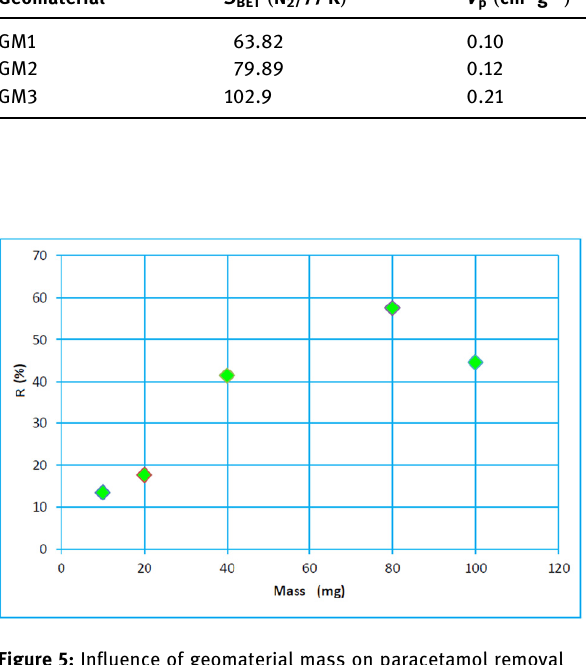
Figure 5: In fl uence of geomaterial mass on paracetamol removal yield.